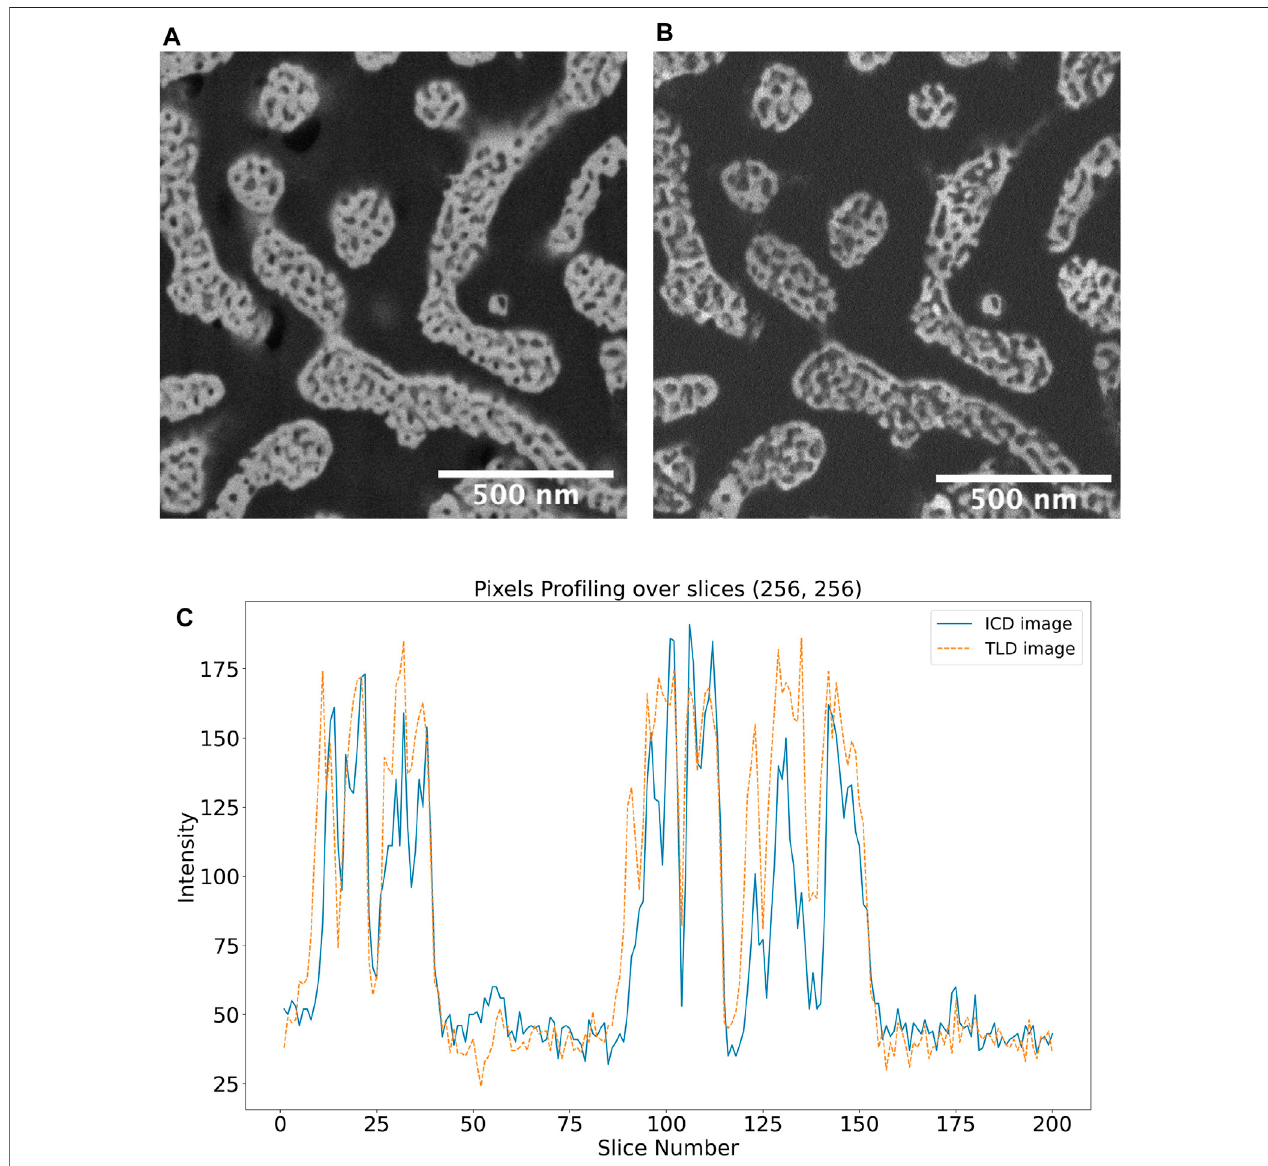
FIGURE 7 | SEM images of hierarchical nanoporous gold simultaneously recorded with (A) TLD and (B) ICD detector (C) intensities of pixel located at a random location in the xy-plane in SEM TLD (orange) and ICD (orange) images.